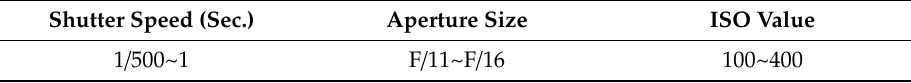
Table 2. Used parameters for camera settings in this